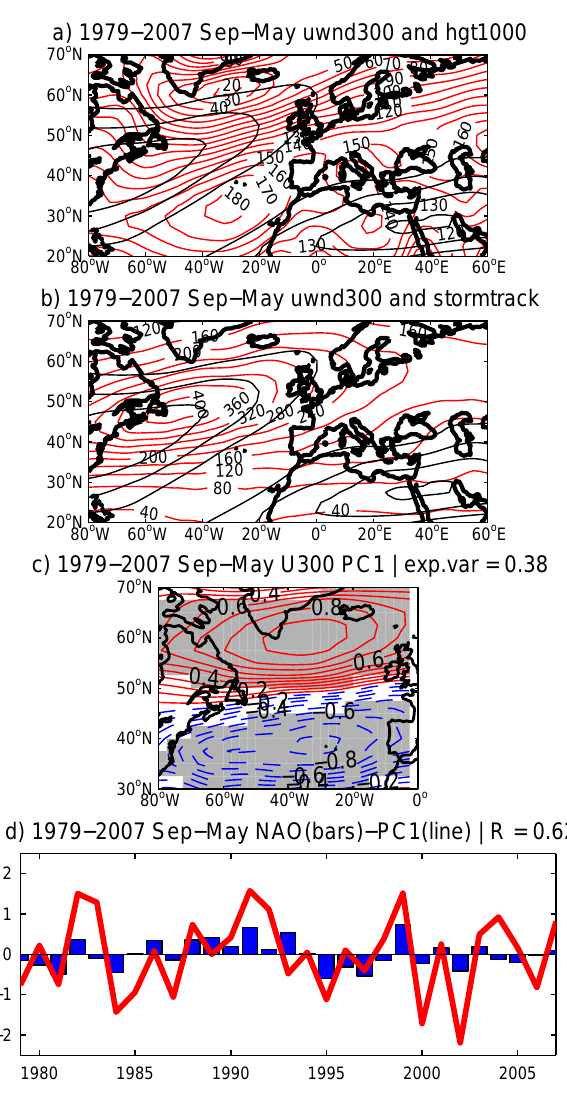
Fig. 1. September to May climatology: (a) geopotential at 1000hPa (m) (red contours); (b) stormtrack at 300hPa (m 2 s − 2 ) (red con- tours); (a) and (b) the zonal wind at 300hPa (black contours, 5ms − 1 interval beginning at 15ms − 1 ) . September to May in- terannual variability: (c) 1st PC of the 300hPa zonal wind (PC1) in homogeneous correlation maps (positive values in red, negative values dashed in blue, 95% significance shaded in gray); (d) PC1 time-series (red line) and NAO index (blue